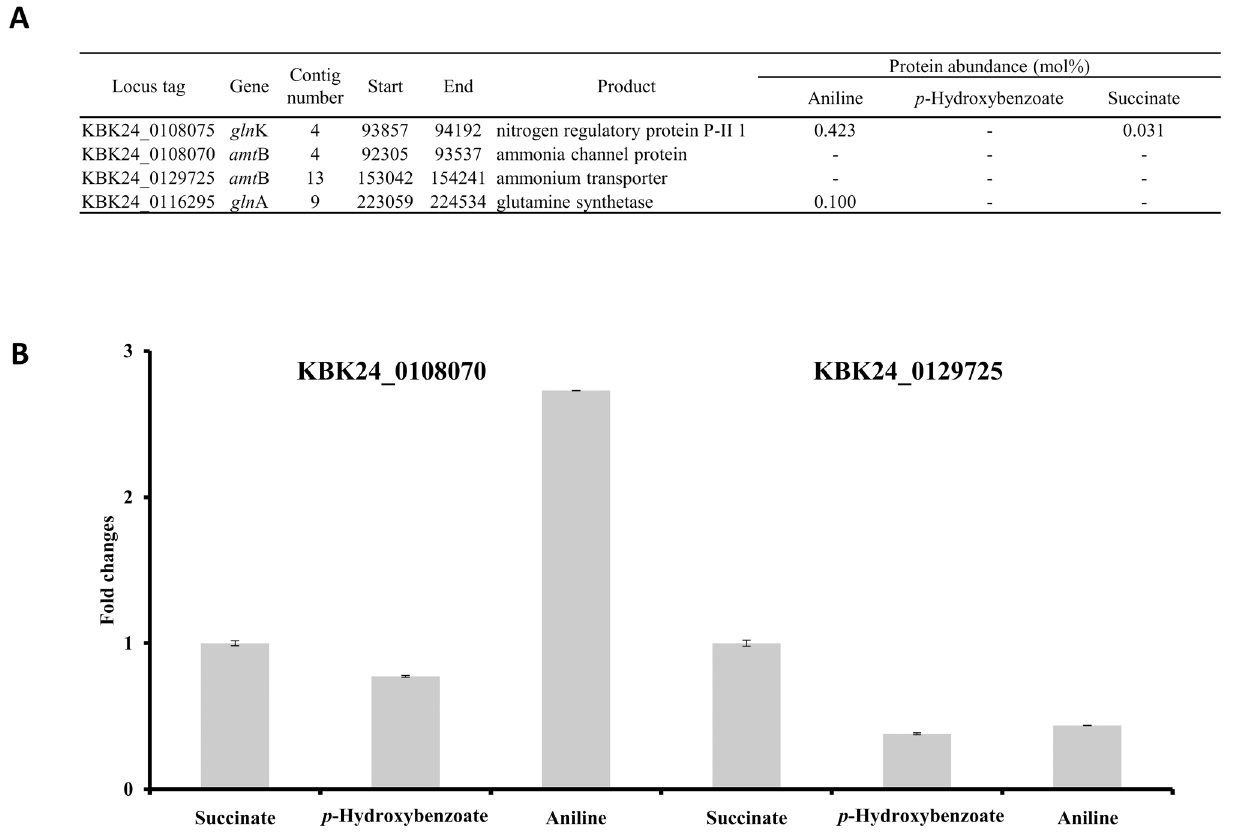
Fig 2. Proteomic evidence of ammonium assimilation enzymes (A), and RT-PCR data for the two amtB genes (KBK24_0108070 and KBK24_0129725) (B) from different Burkholderia sp. K24 culture